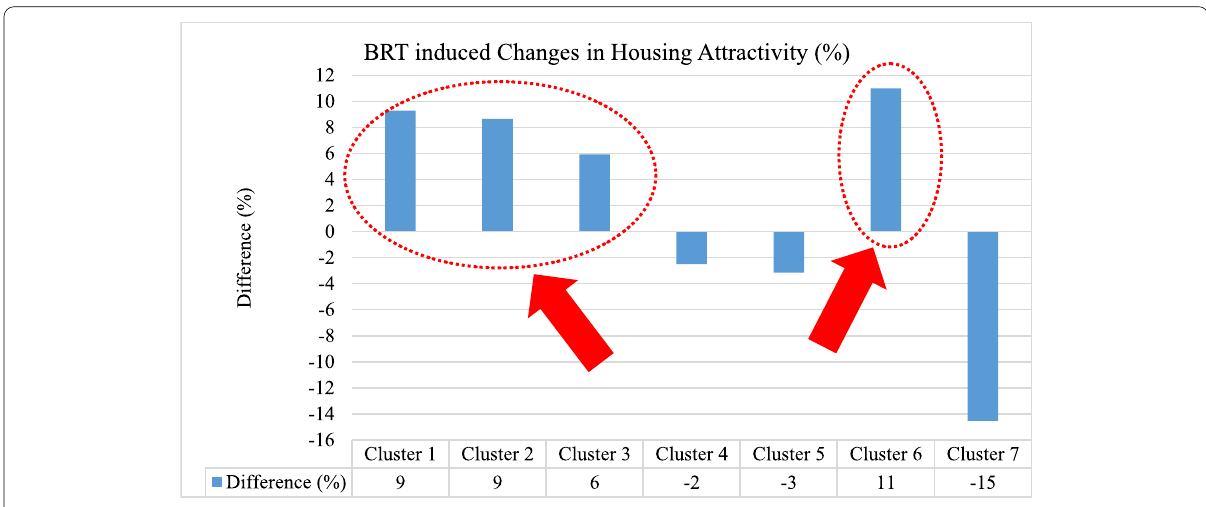
Fig. 11 Effects of BRT on Cluster Selection for new urban development